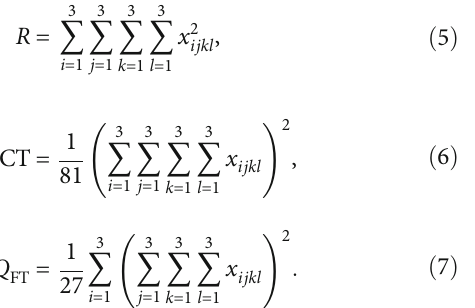
f ) and the failure principal stress line (